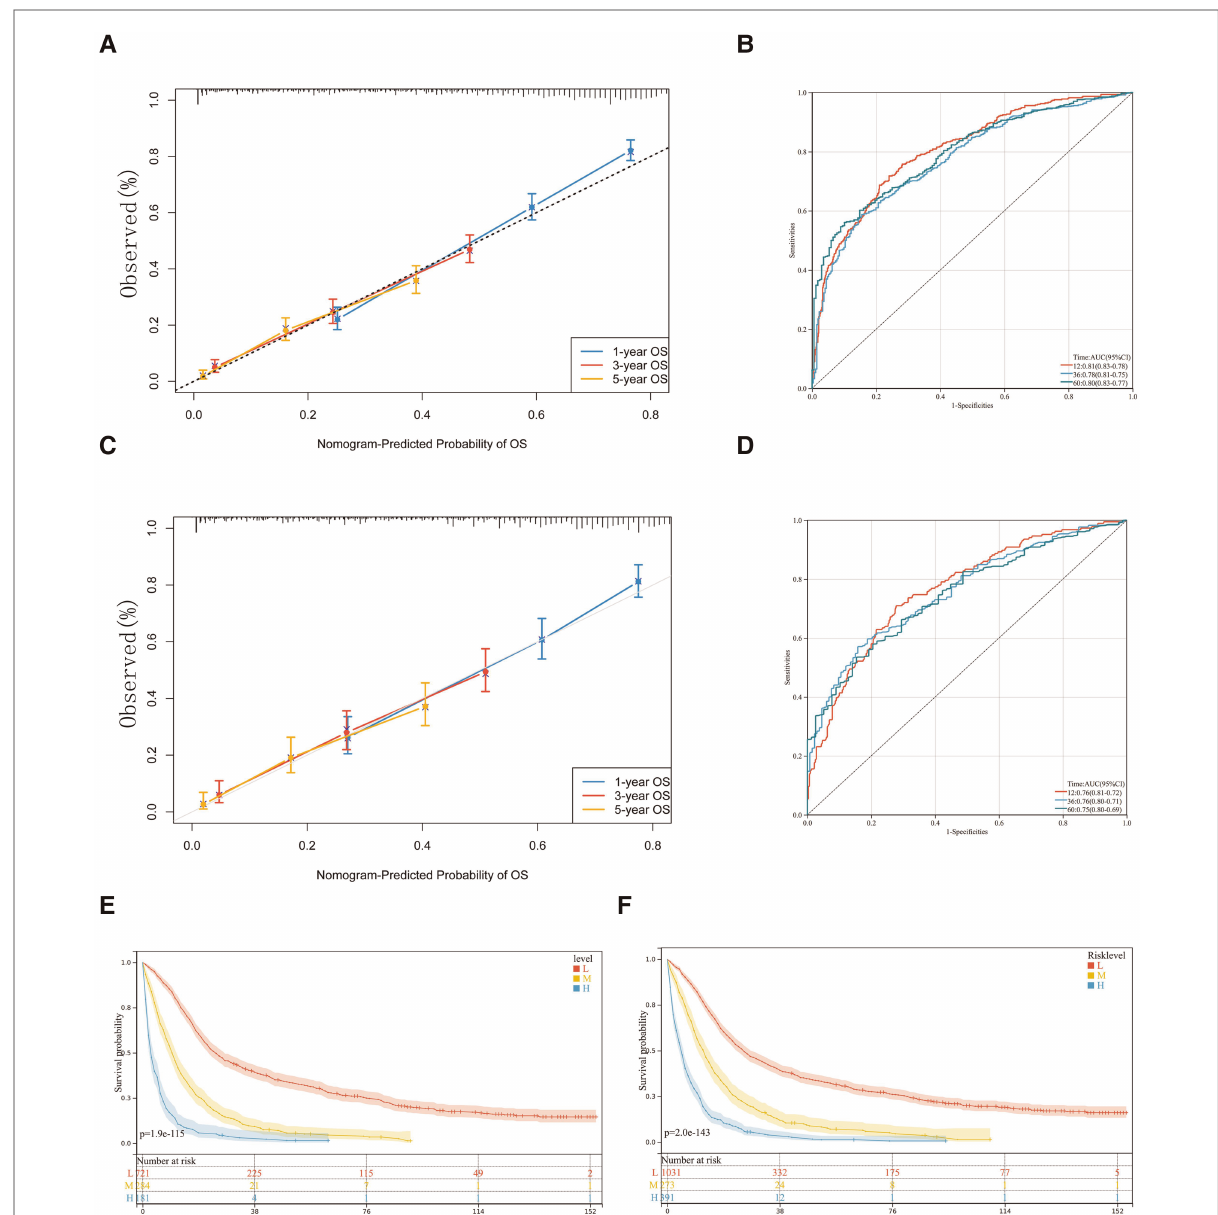
FIGURE 4 Calibration slope and receiving operating characteristic (ROC) curve of our model. The 1-year, 3-year and 5-year calibration curves for the training set ( A ) and validation set ( C ) are also close to the ideal straight line with a slope of 1. In ROC curves of training set ( B ) and validation set ( D ), nomogram has high accuracy in predicting the prognosis of patients with pCCA. Kaplan-Meier curves for the OS of pCCA patients in different level of risk in training set ( E ) and total set ( F ) according to